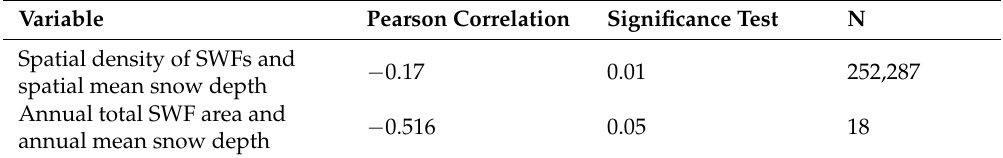
Table 3. Correlation between SWFs and snow depth during the period of 2001–2018.